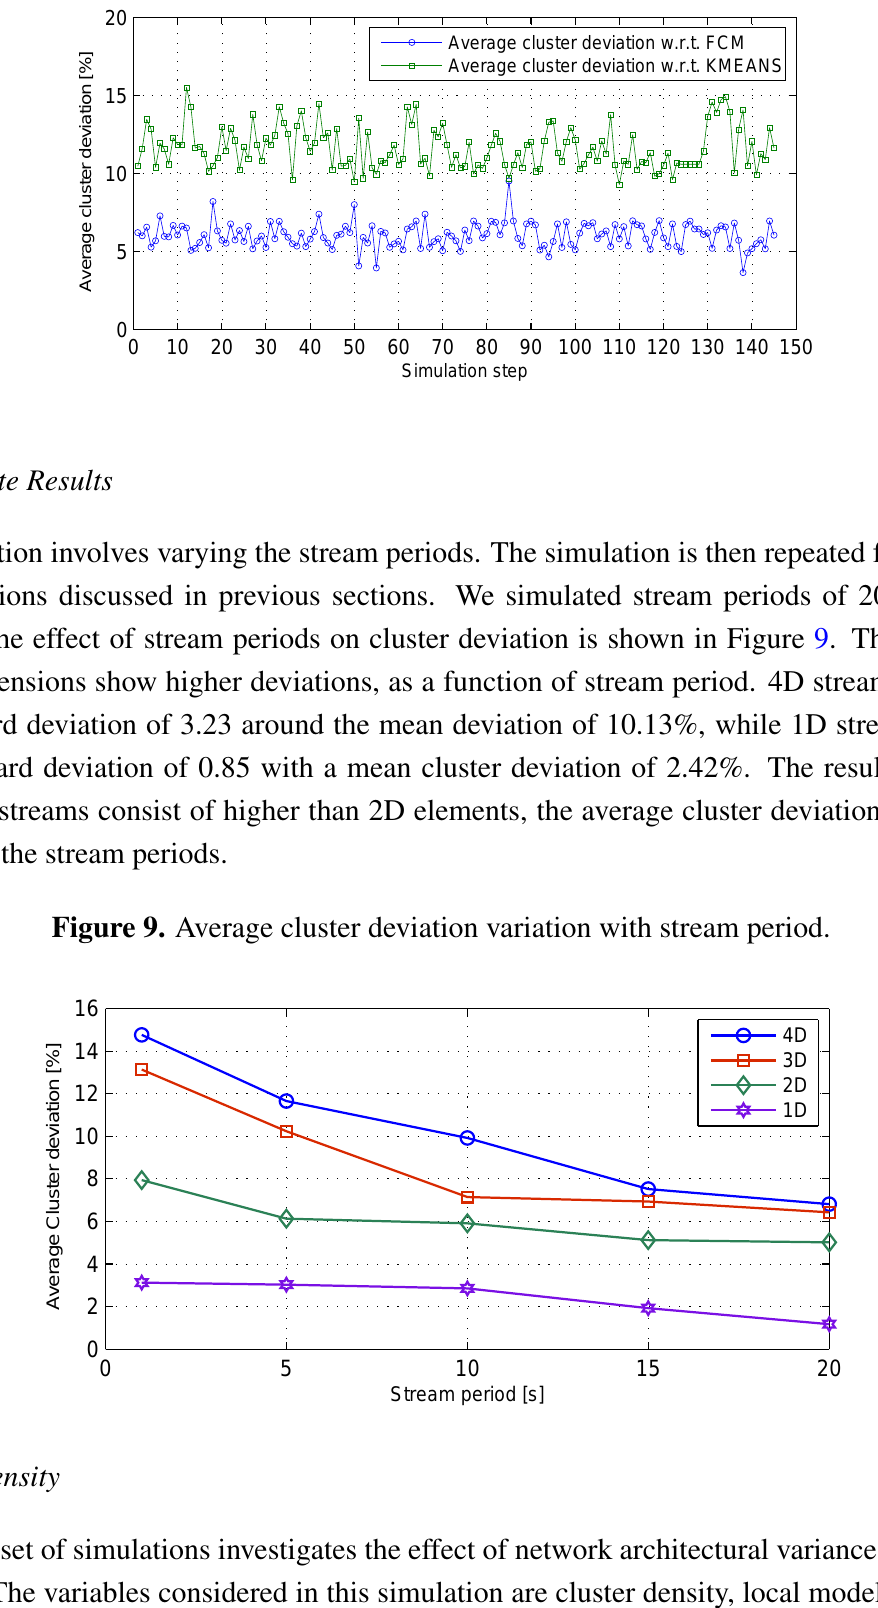
Figure 8. Average cluster deviations with respect to k-means and FCM for 3D streams.